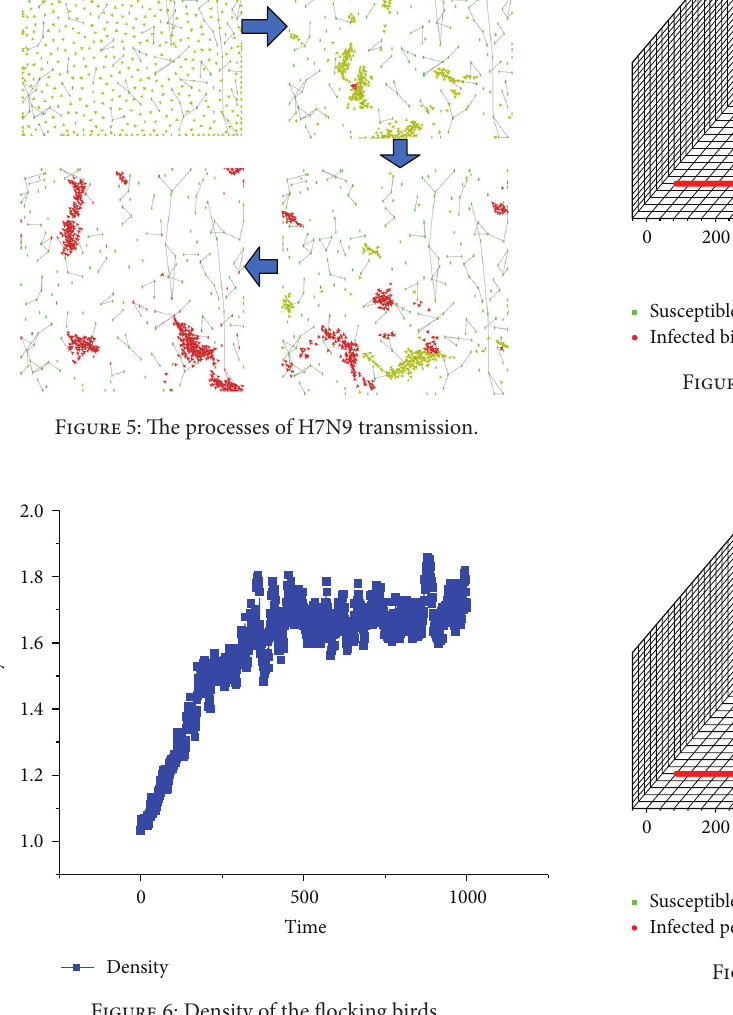
Figure 6: Density of the flocking birds.